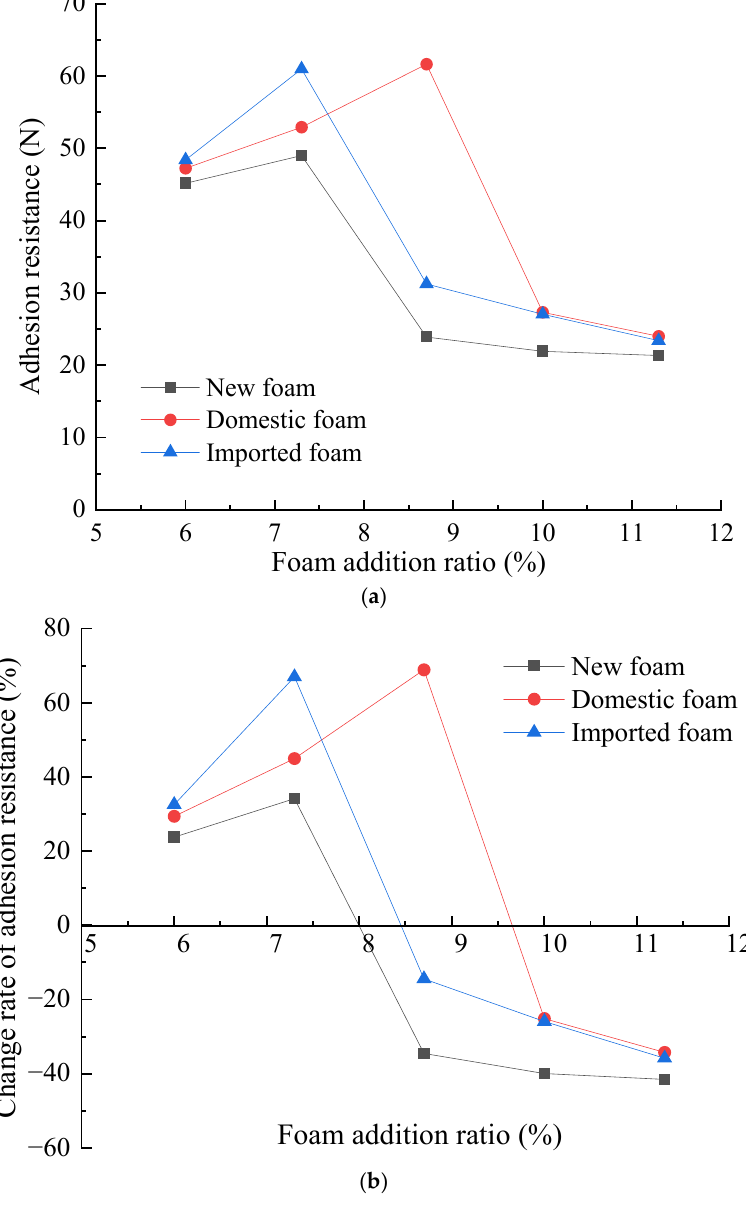
Figure 14. Comparison of adhesion resistance and adhesion resistance rate of sand soil modified by different foam agents. ( a ) Adhesion resistance change curve. ( b ) Adhesion resistance change rate change